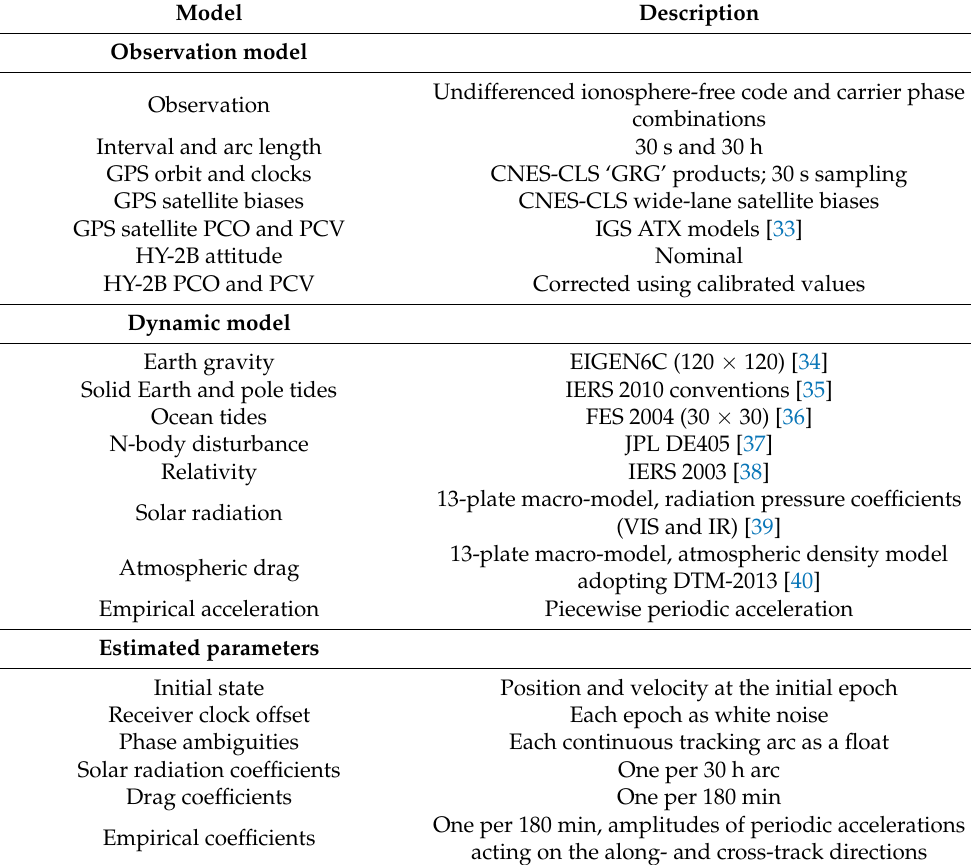
Table 1. Force models and datasets for HY-2B precise orbit determination and SLR